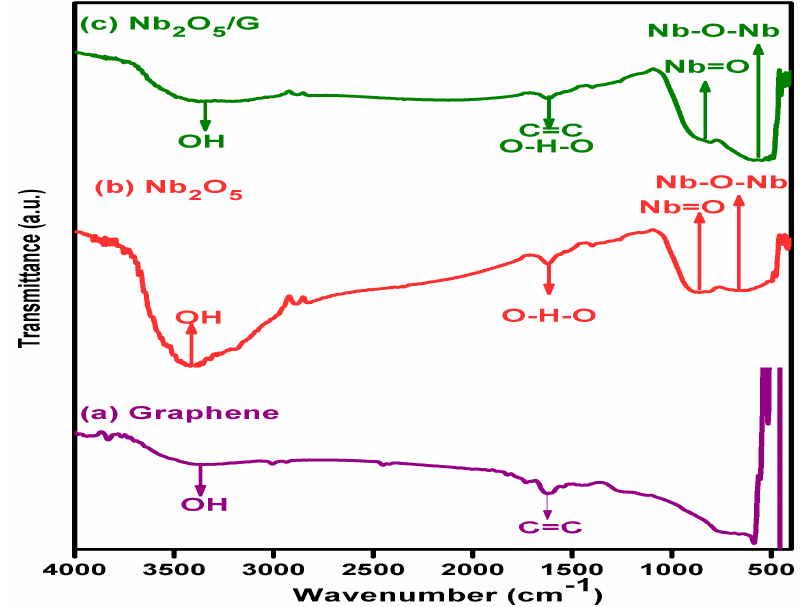
Figure 4. FTIR spectra of ( a ) graphene, ( b ) Nb 2 O 5 , and ( c ) Nb 2 O 5 /G nanocomposite.